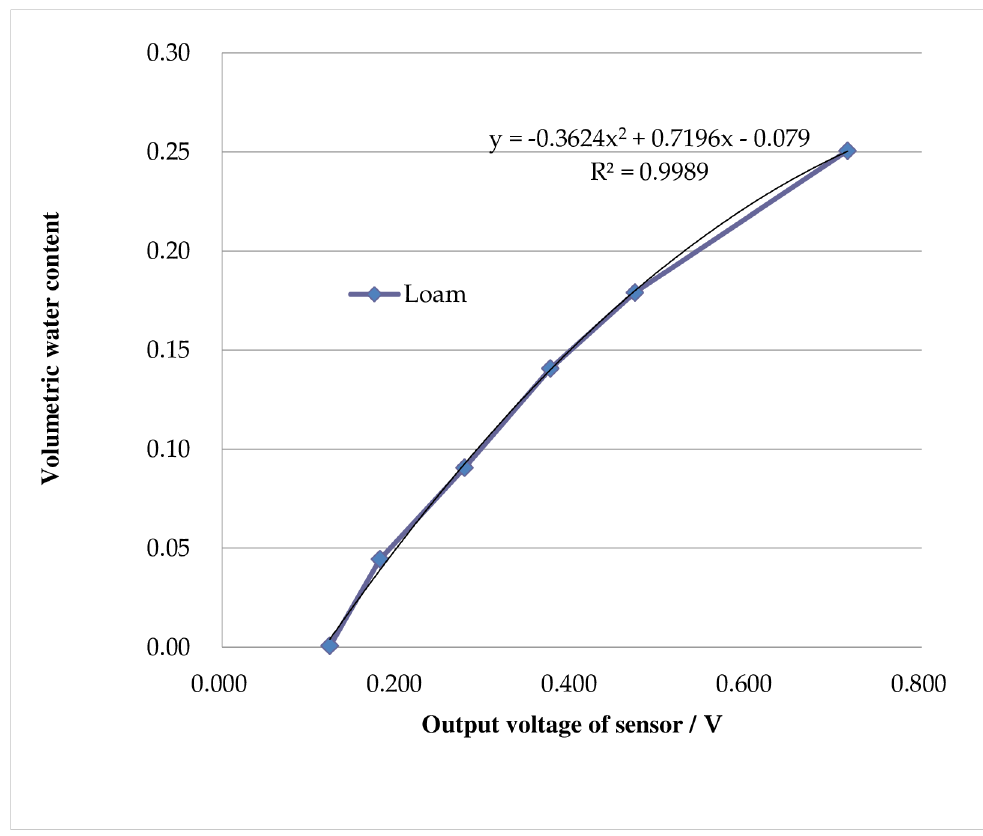
Fig 5. Calibration results of the soil water content